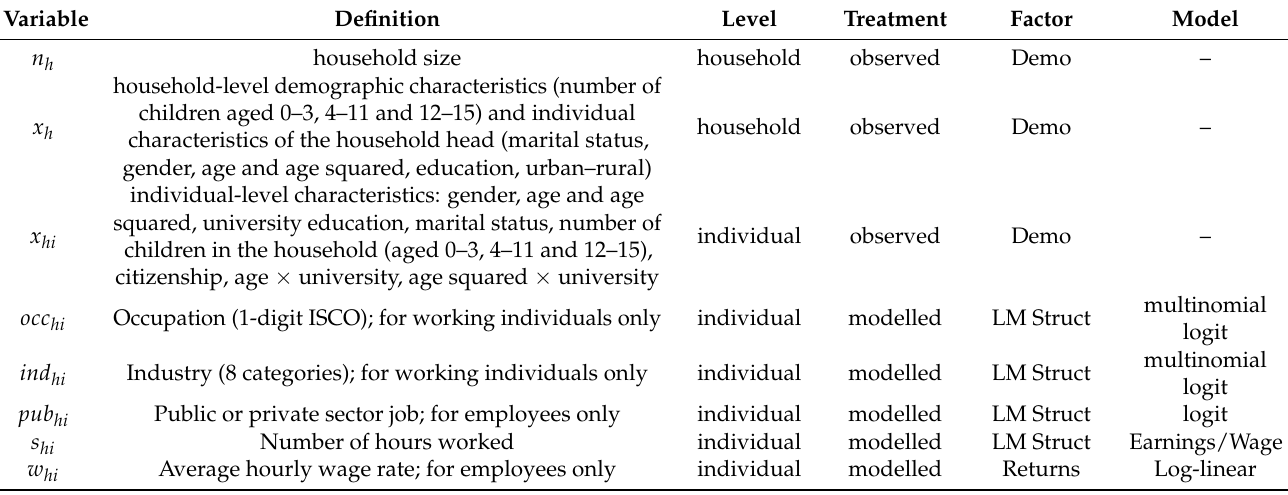
Table A2. Demographic and labour market variables.